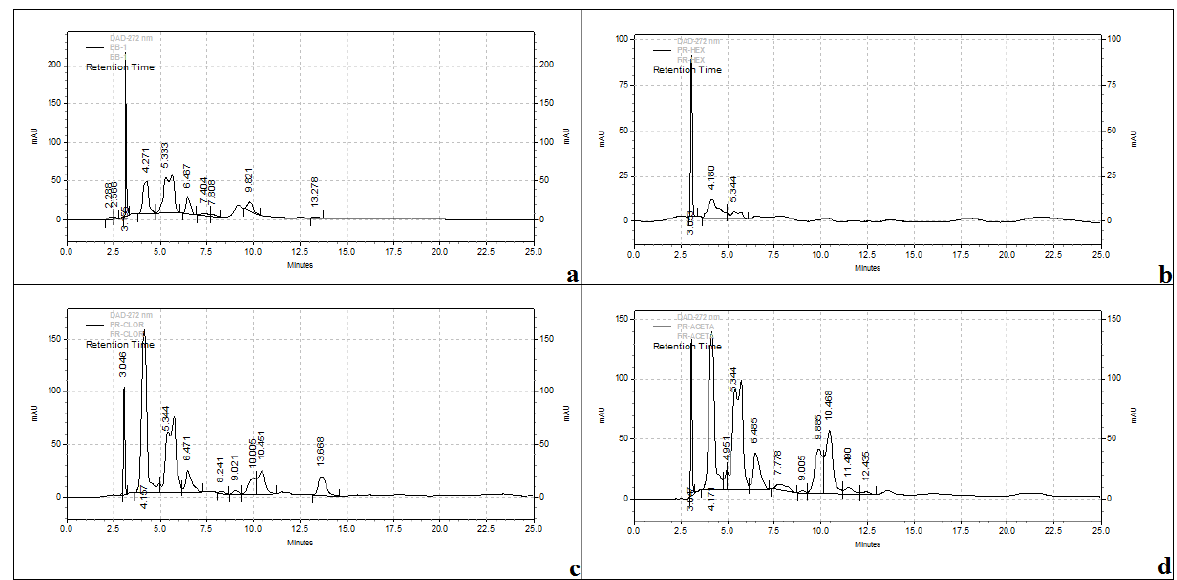
Figure 1. Chromatogram of the sample. a: ethanol extract; b: Hexane fraction; c: Chloroform Fraction; d: ethyl acetate fraction.